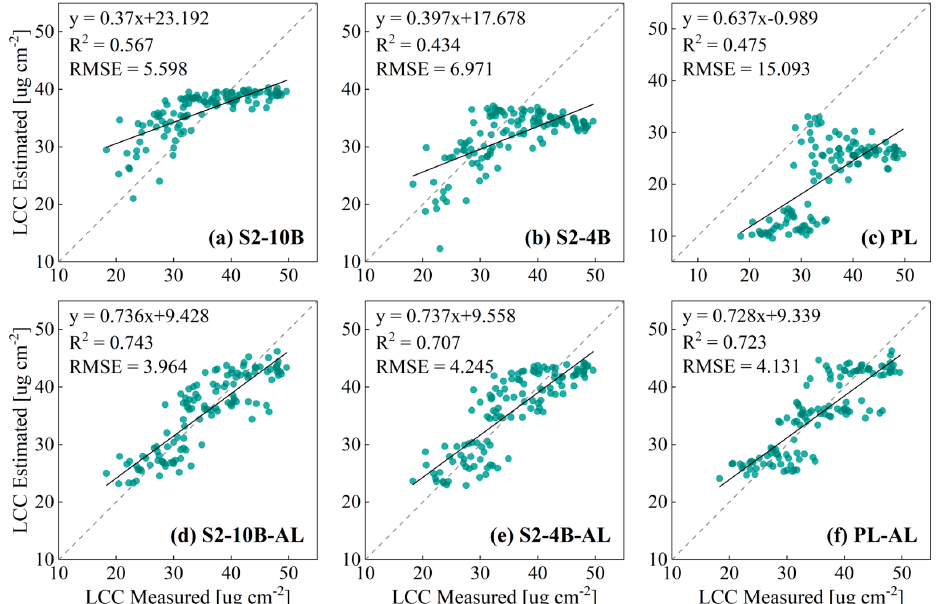
Figure 2. Relationship between the measured and retrieved LCCs in Dajianchang town using the hybrid model and ( a ) Sentinel-2 imagery with 10 bands, ( b ) Sentinel-2 imagery with 4 bands, and ( c ) Planet imagery without the AL strategy; ( d – f ) the results using the hybrid model and three types of images with the AL strategy, respectively.